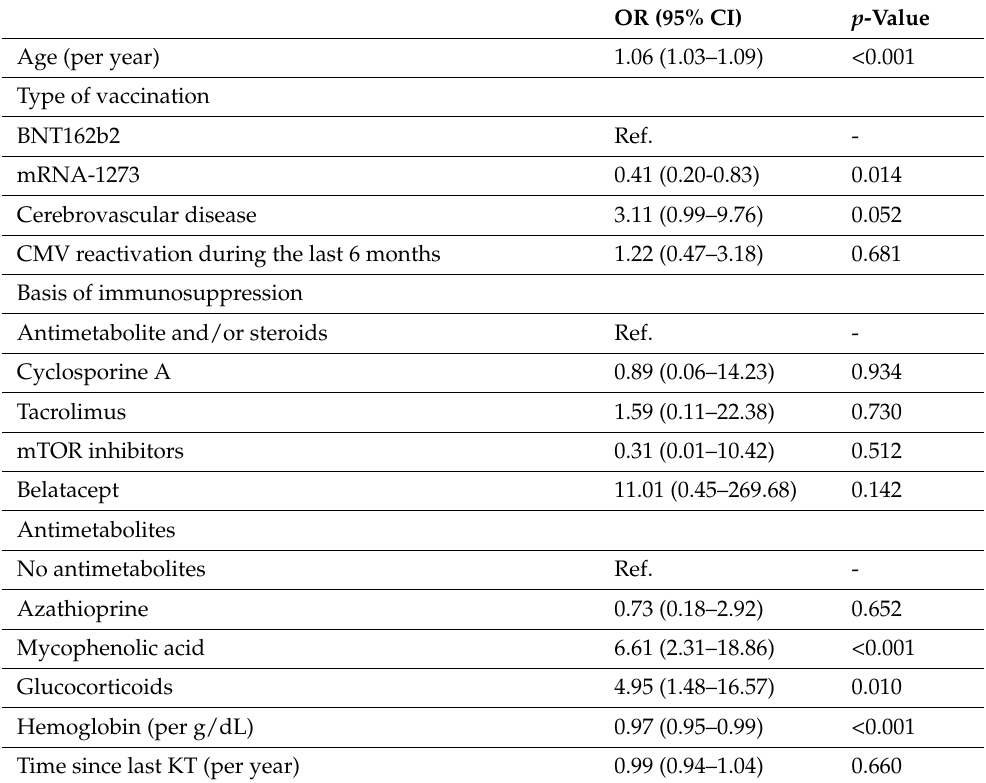
Table 5. Multivariate analysis of risk factors for non-response in KTR. OR odds ratio, CI confidence interval, KT kidney